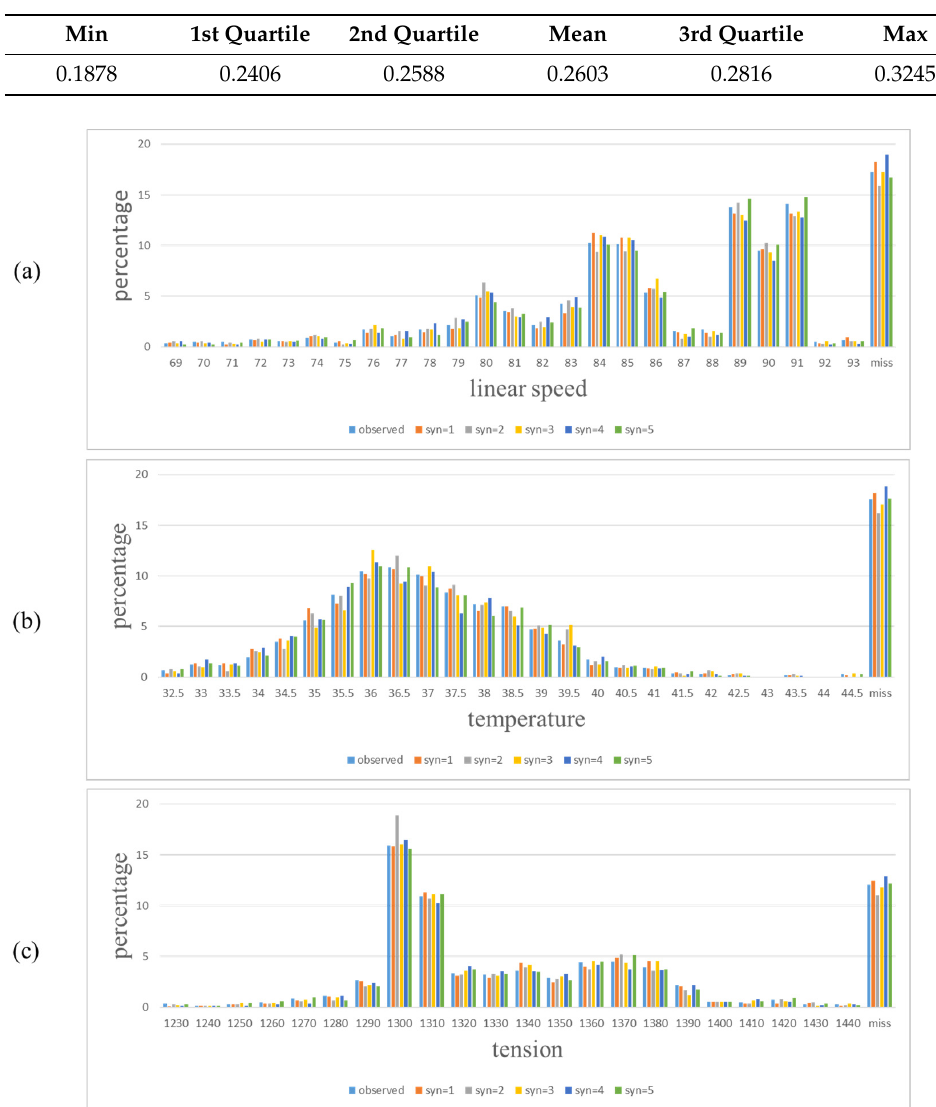
Table 1. The statistics of 100 MCCs based on the synthesis data.